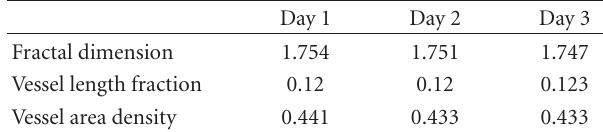
Table 1: Fractal dimension, vessel length fraction, and vessel area density obtained from the images of days 1, 2, and 3 from Figure